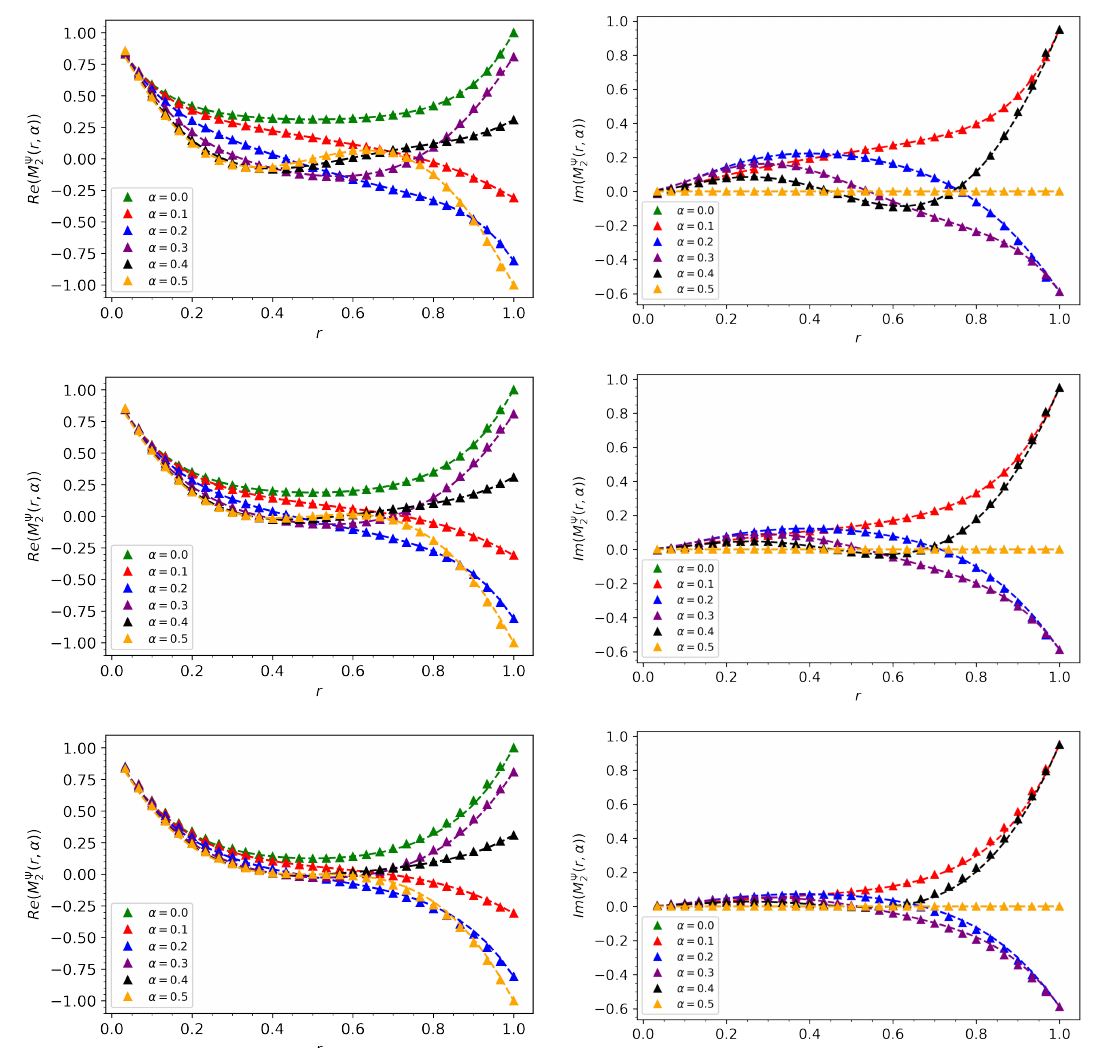
( r ; α ) Figure 3 . Numerical data (triangles) versus analytical predictions (dashed lines) for M 3 + 2 (top row), M 2 + 1+ ( r ; α ) (central row), and M 1 + 1 + 1 + ( r ; α ) (bottom row). We consider n = 2 , system 2 2 size L = 30 with m = 0 . 1 . The left/right panels in each row show the real/imaginary part of the function. In each rows we take values of the flux α = 0 , 0 . 1 , . . . 0 . 5 . The numerics for the top